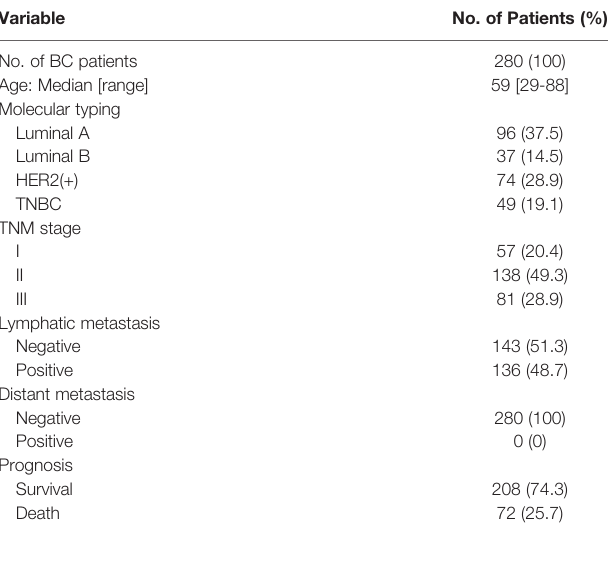
TABLE 1 | Patient characteristics.